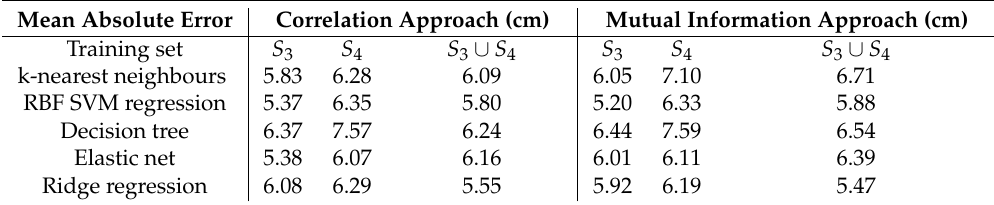
Table 6. Accuracy comparison of different training sets for the different machine learning algorithms validated on S 1 .